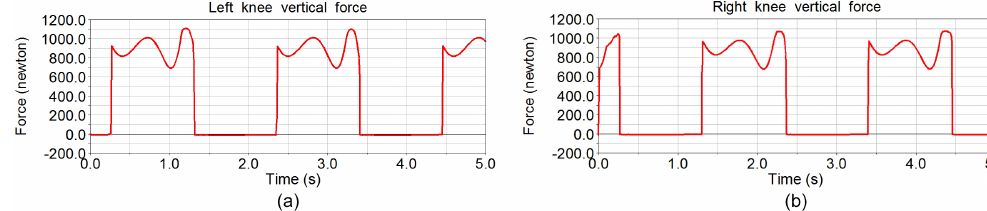
Figure 20. Computed vertical reaction force on the exoskeleton knee joint: (a) left knee; (b) right